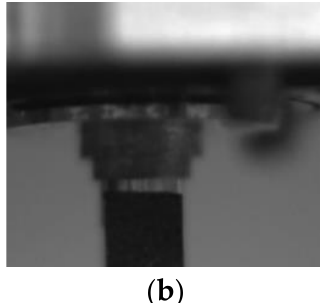
side view of sleeve after posture adjustment.